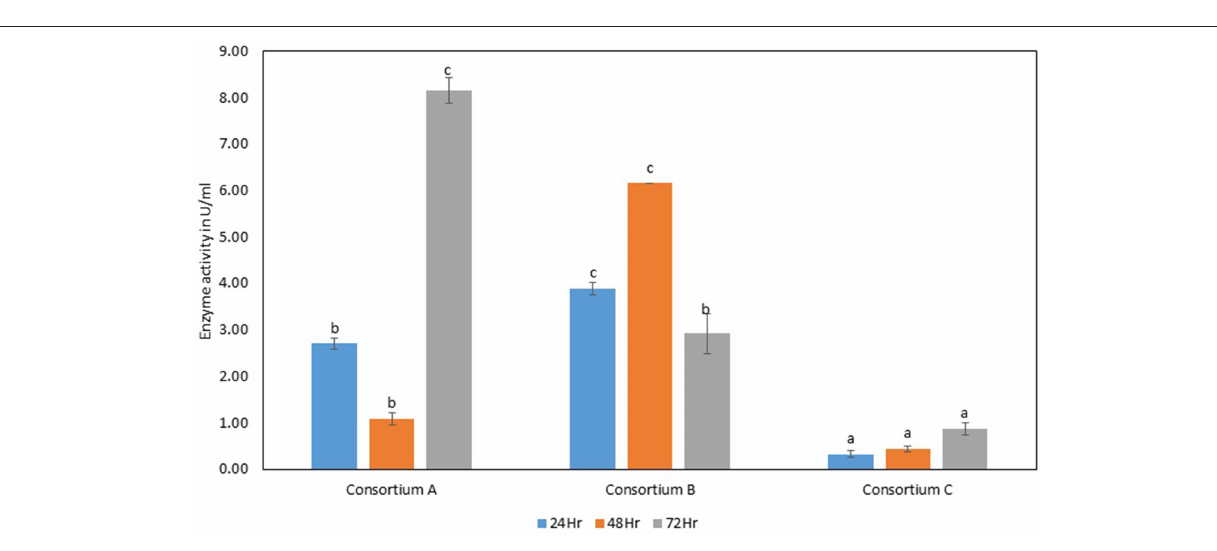
by consortium C showed 0.13, 0.21, and 0.28 Uml − 1 at